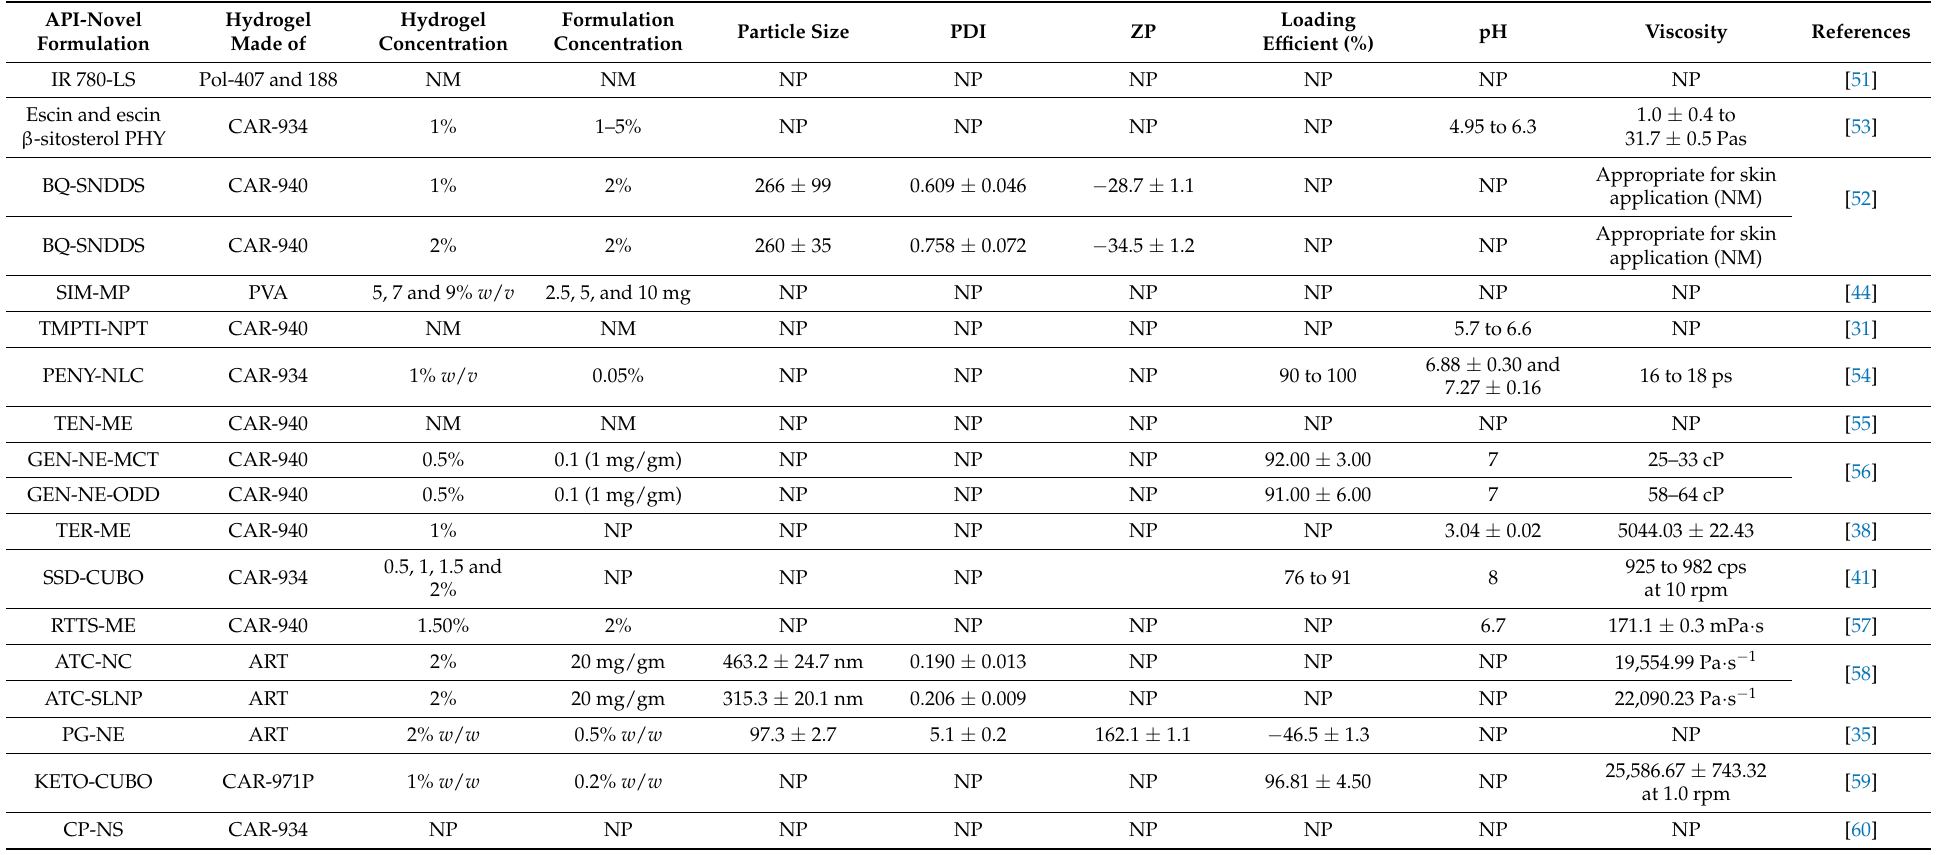
Table 7. Physical evaluation studies for novel hydrogel formulation prepared with synthetic gelling